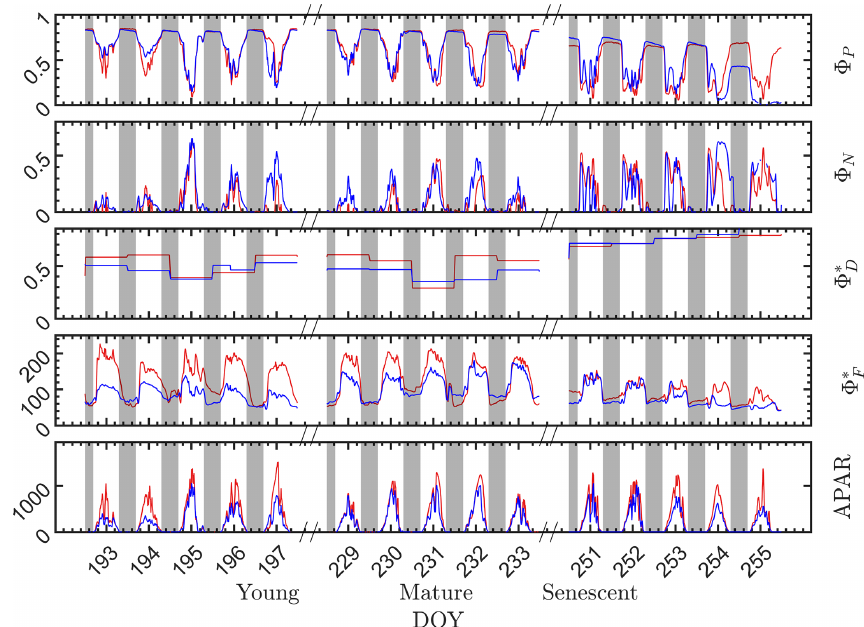
Figure 4. Photosystem energy partitioning obtained from in situ active fluorescence measurements made on individual leaves of a corn canopy during the 2017 growing season. Shown are the absolute light use efficiency of photochemistry ( (cid:56) P ), the reversible heat dissipation ( (cid:56) N ), the relative light use efficiency of sustained heat dissipation ( (cid:56) ∗ ), the relative light use efficiency of fluorescence ( (cid:56) ∗ ) and the D F photosynthetically active radiation absorbed by individual leaves (APAR leaf µmolm − 2 s − 1 ) for sunlit leaves (red lines) and shaded leaves (blue lines). The nighttime periods, from sunset to sunrise of the next day, are marked with gray